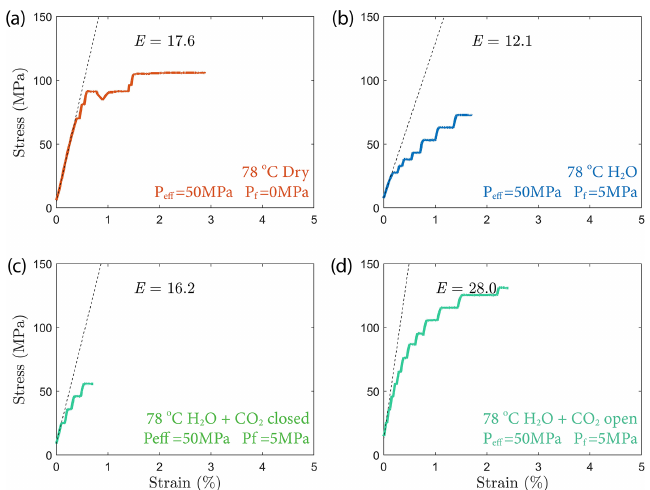
Figure A9. Elastic modulus calculated from strain vs. stress plots from (a) dry, (b) H 2 O, (c) H 2 O + CO 2 closed and (d) H 2 O + CO 2 open